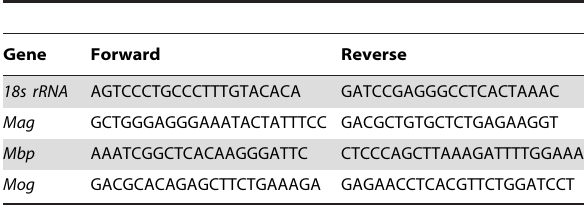
Table 2. Primers used in quantitative PCR for amplification of transcripts in rat primary cultures.